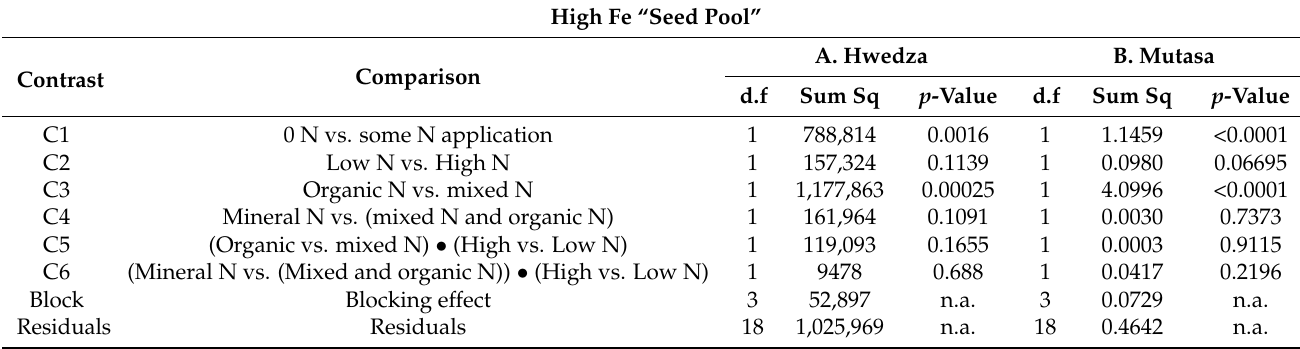
Table 8. ANOVA of contrasts showing effect of N management strategy on grain yields of the high Fe finger millet “seed pool” in Hwedza and Mutasa. High Fe “Seed